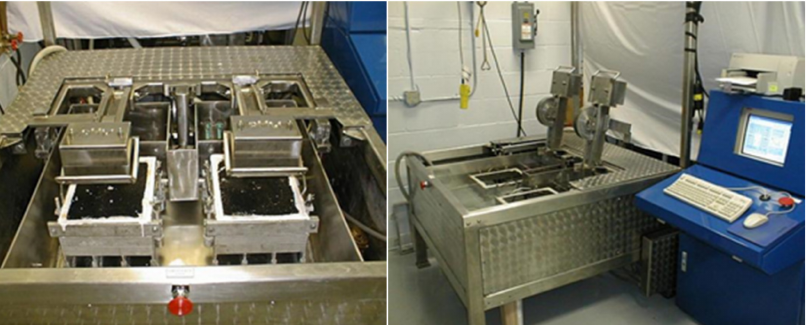
Figure 8. Hamburg test